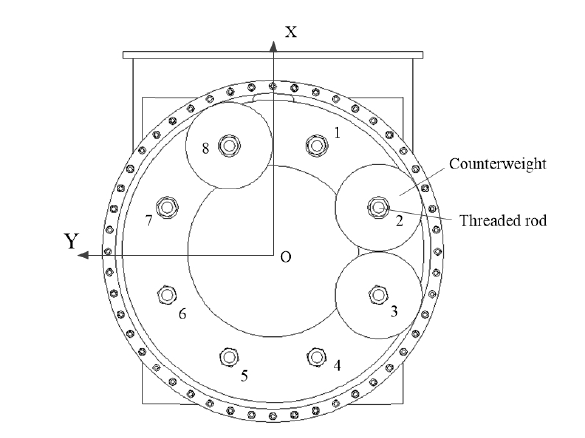
Figure 5. Counterweight components of the simulated